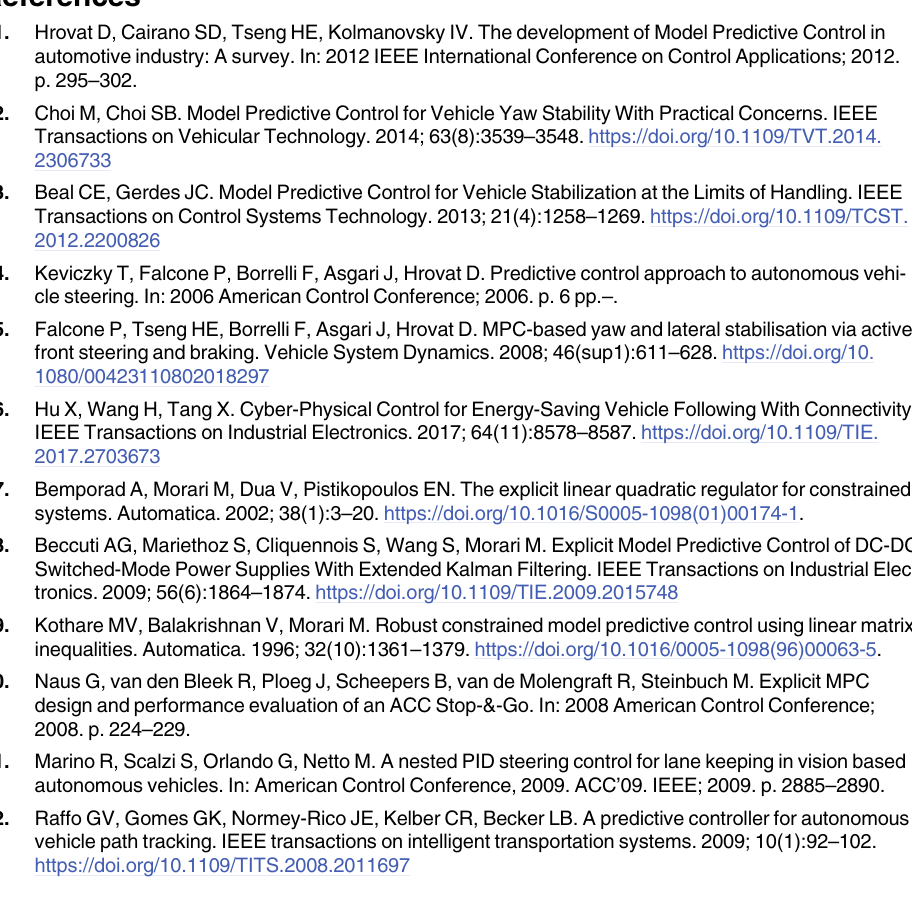
S1 Table. Detailed information about explicit controllers with different prediction and input